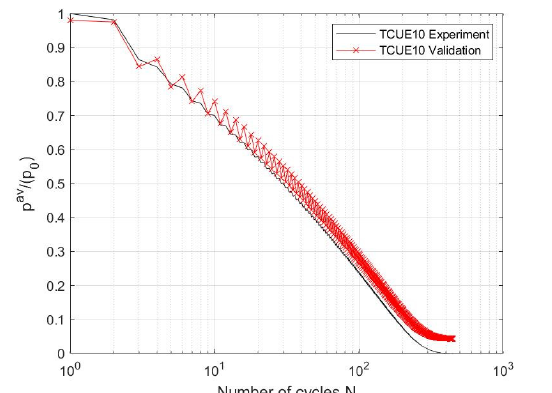
Fig. 9 Relaxation of normalized average mean effective stress p av =p 0 with increasing number of cycles in undrained cyclic triaxial tests with prescribed strain amplitude ( I D0 = 0.56 and p 0 =200